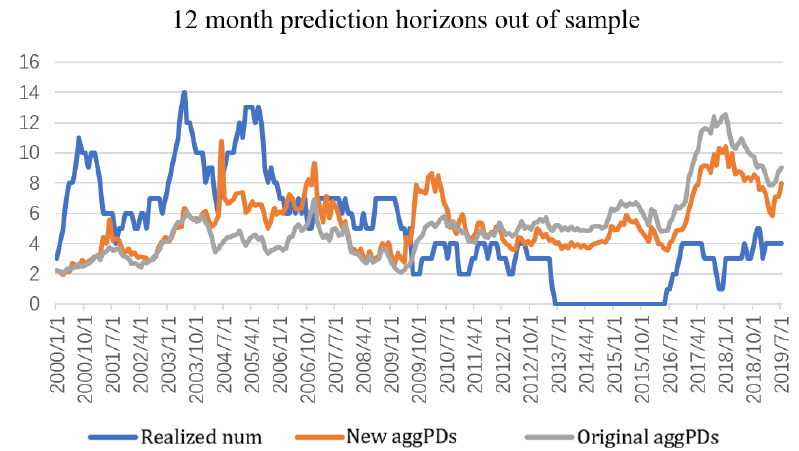
Figure 4. This figure shows a comparison of the realized number of defaults, original aggregated accumulated PDs, and new aggregated accumulated PDs for a 12-month prediction horizon out of sample.